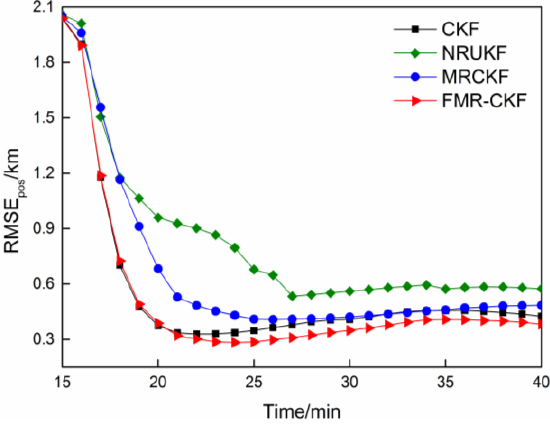
Figure 2. The RMSE pos comparison when there are no outliers.